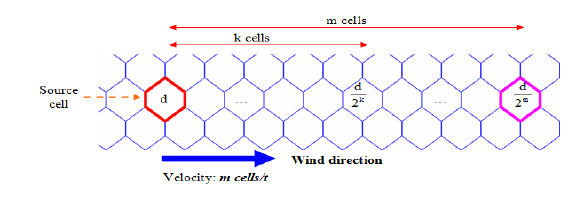
Figure 9. Estimationof propagatedadult hoppersdue to wind.